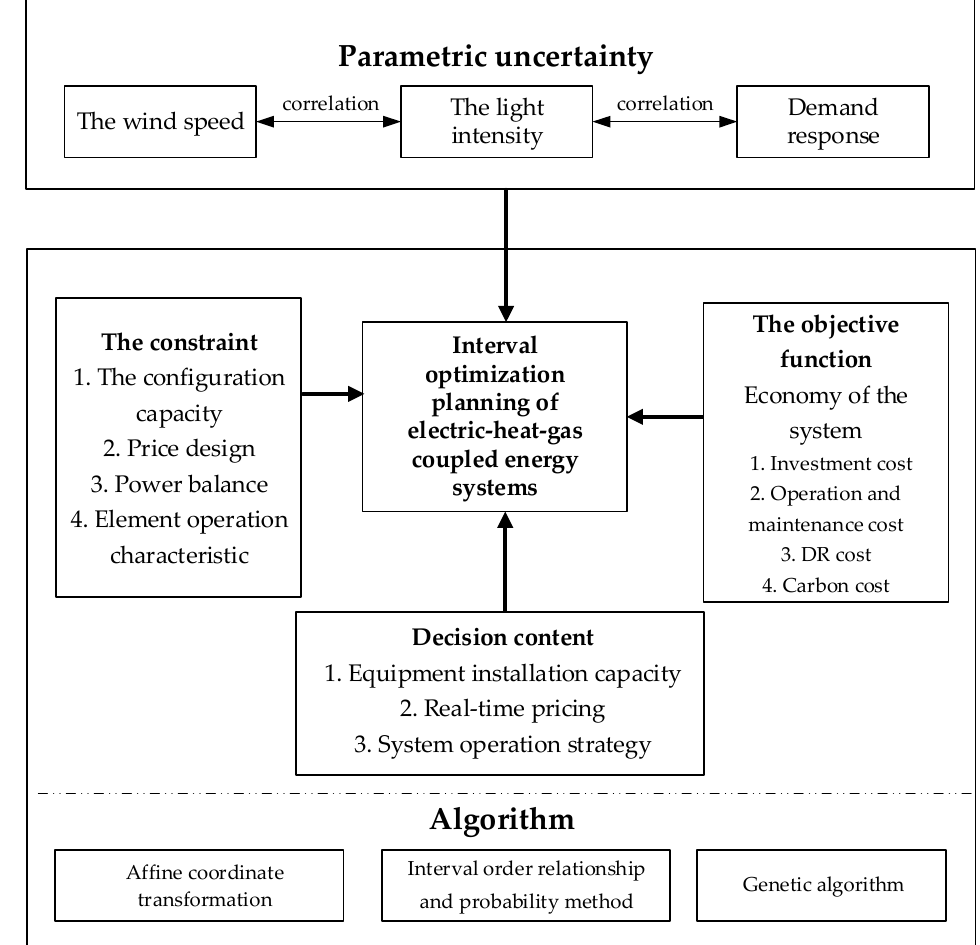
Figure 2. Framework of EH with the correlation between uncertainties.